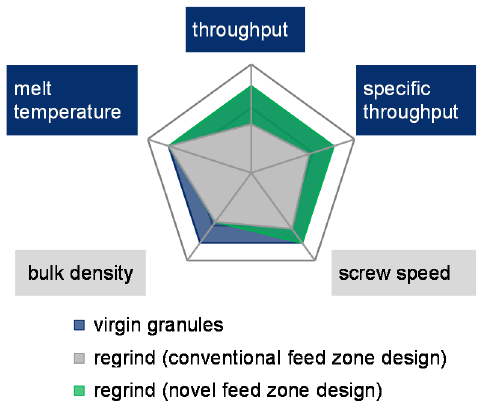
Figure 23. Increased process window for the processing of regrind material.